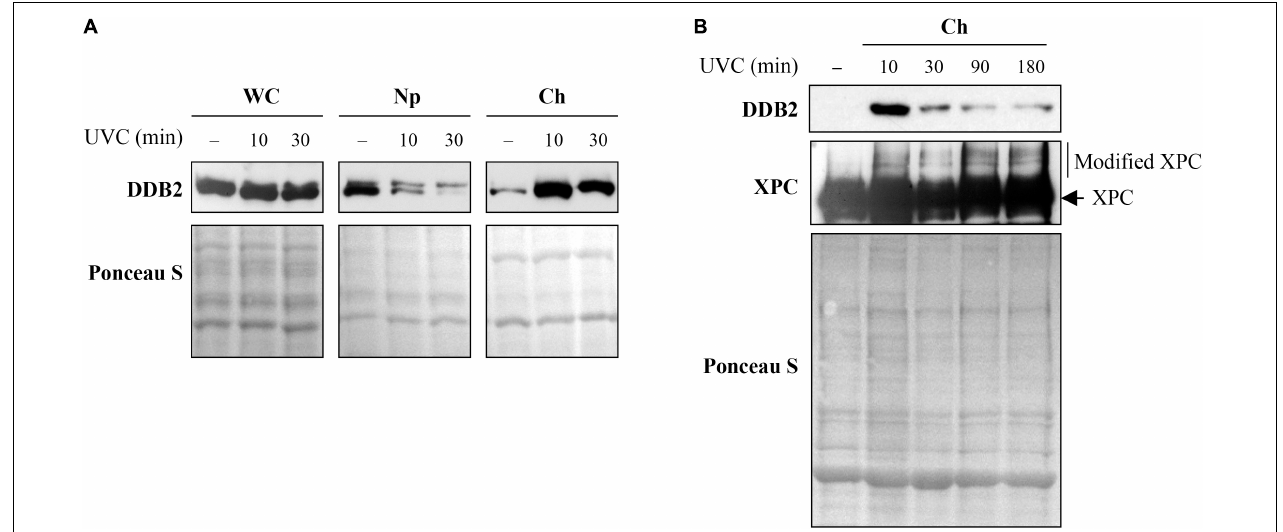
FIGURE 5 | Sub-cellular and sub-nuclear fractionation of globally UVC-irradiated cells to identify movement and localization of NER proteins to UV-damaged chromatin. The GMU6 cells globally irradiated with 10 J/m 2 were fractionated and subjected to Western blot analysis. Ponceau S staining was used as control for loading. (A) The sub-cellular fractions were probed for DDB2 to demonstrate its significant time-dependent depletion in the nucleoplasm and concomitant accumulation in the chromatin-bound protein fraction signifying its movement from inside the nucleus to damaged site on the chromatin in response to global UV-irradiation of the cells. (B) Kinetics of arrival and departure of DDB2 and treatment-dependent post-translational modification of XPC in the chromatin-bound protein fraction extracted at different time points after global UVC irradiation. Ponceau S staining was used as loading